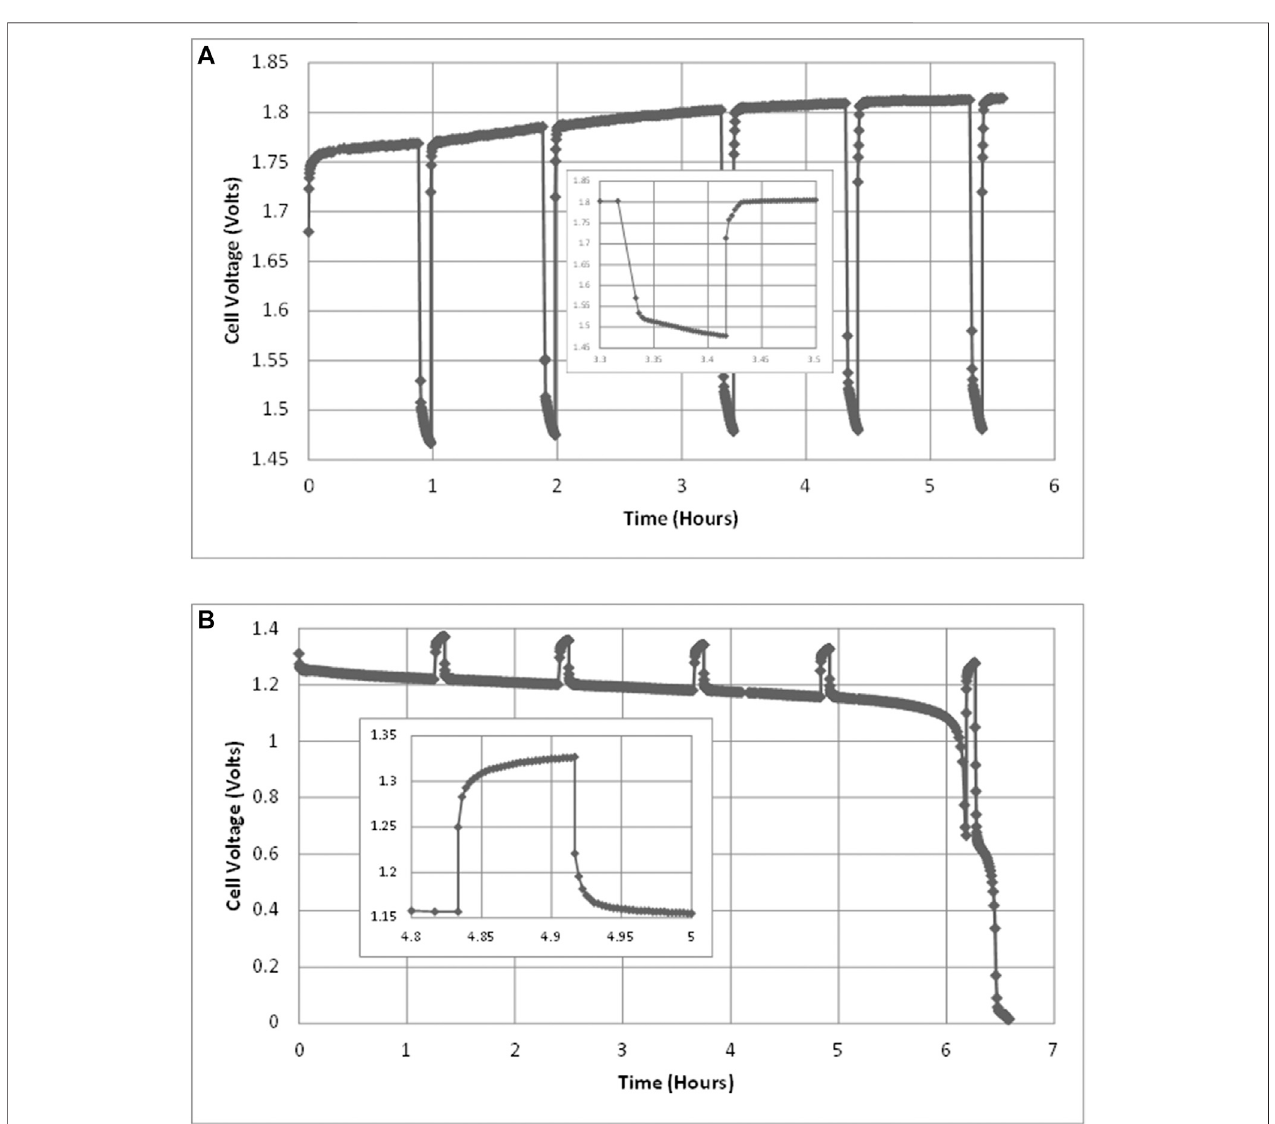
FIGURE 3 | Cell voltages during (A) charging test at 1.5 A, 40 ° C and (B) discharging test at 0.6 A, 40 ° C. Each test includes fi ve interruption tests of 5 min each. An example interruption is shown in each, enlarged and inset.